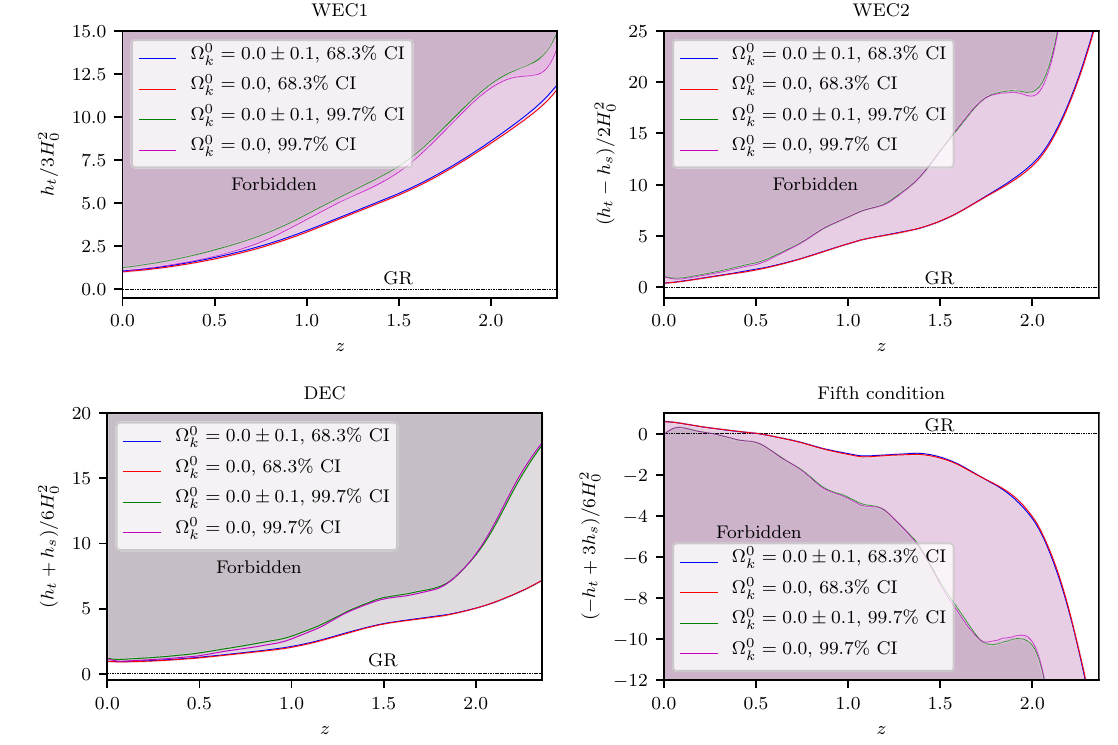
Fig. 3 The green and pink solid lines are the 99 . 7% CIs of the WEC1, WEC2, DEC and fifth condition (FEC) observational bounds. The shaded areas cover the values for which the functions f ( h t , h s ) can-